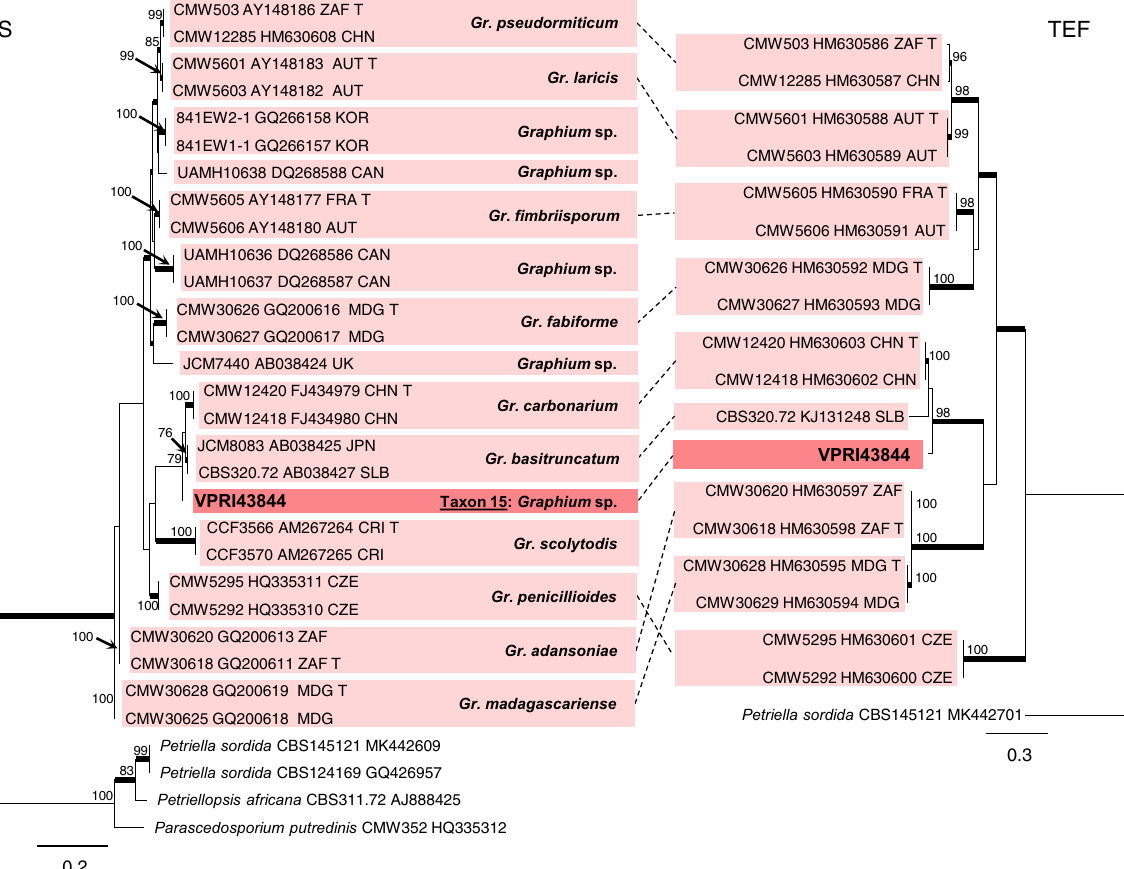
0.9. ML bootstrap values of 70% are recorded at nodes. T ex-type ≥ ≥ =